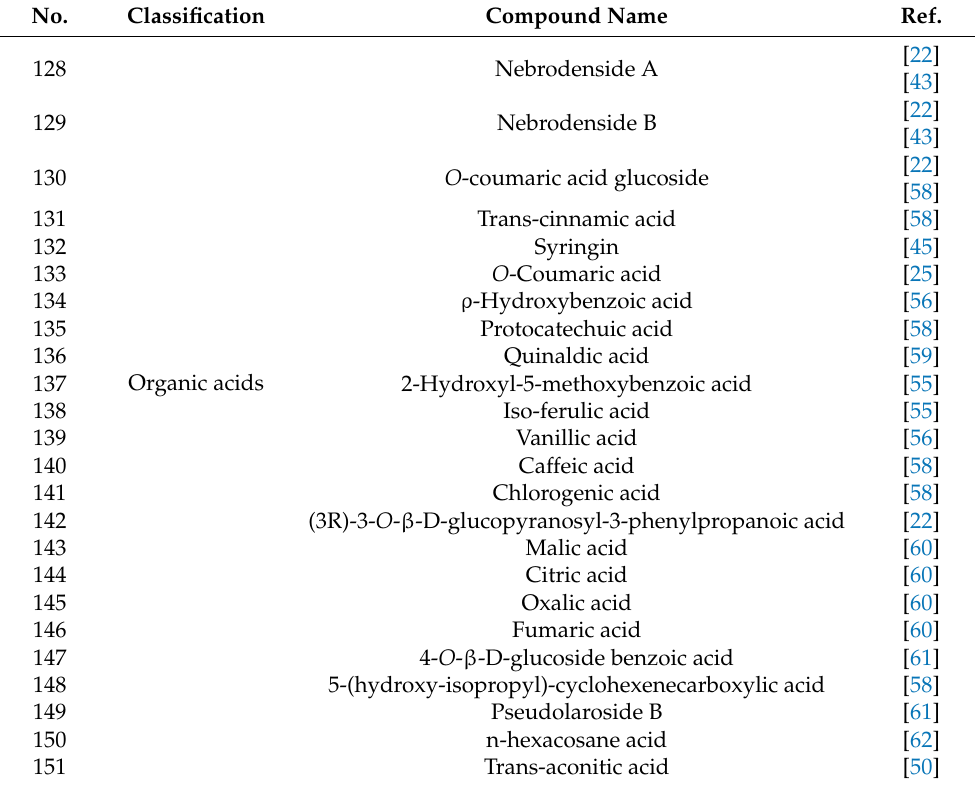
Table 4. Organic acids in Ephedra sinica Stapf (structural formulas are shown in Figure S4). No. Classification